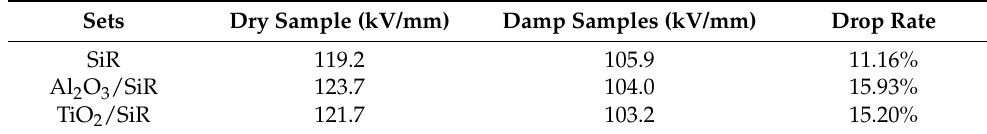
Figure 8. Weibull distribution of the DC breakdown strength of SiR composite. Table 1. Comparison of DC breakdown strength of dry and wet samples.